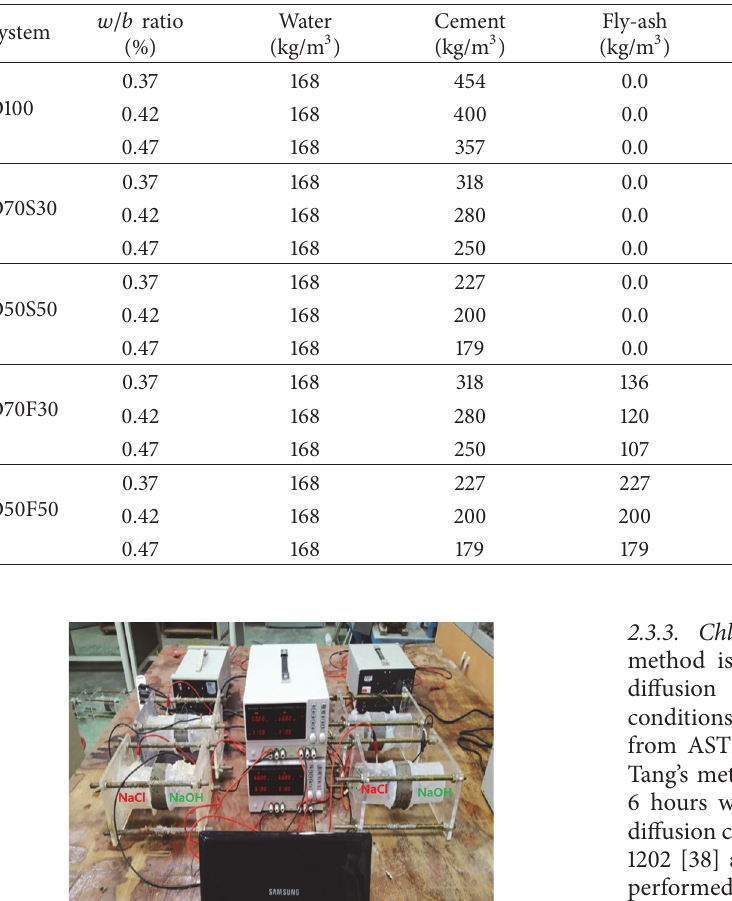
Table 2: Mixing proportion of HPC.